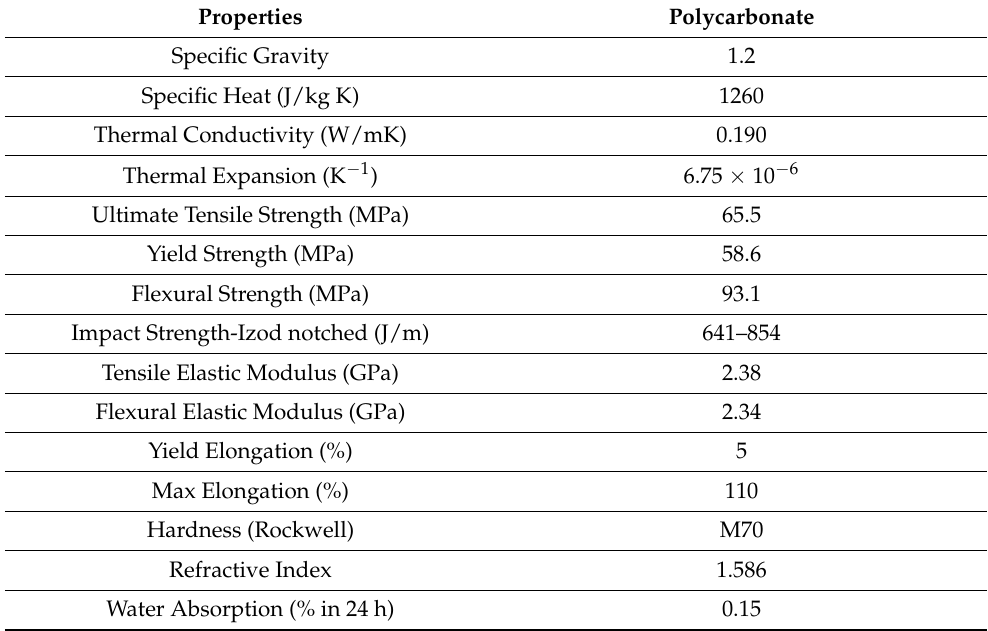
Table 4. General properties of Polycarbonate